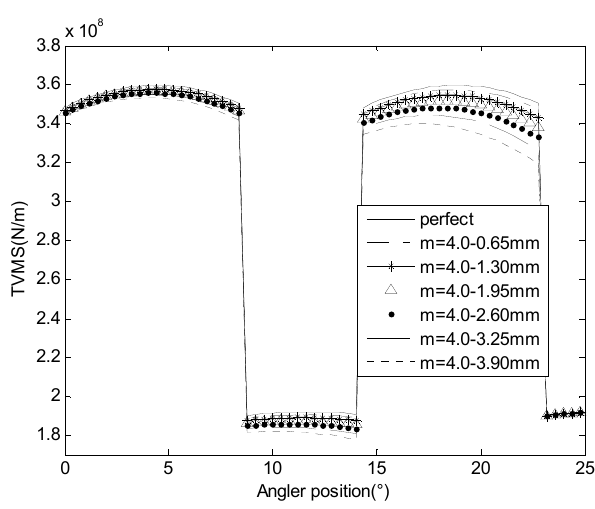
Figure 18. Meshing stiffness for the cracked gear under the 4 mm modulus.